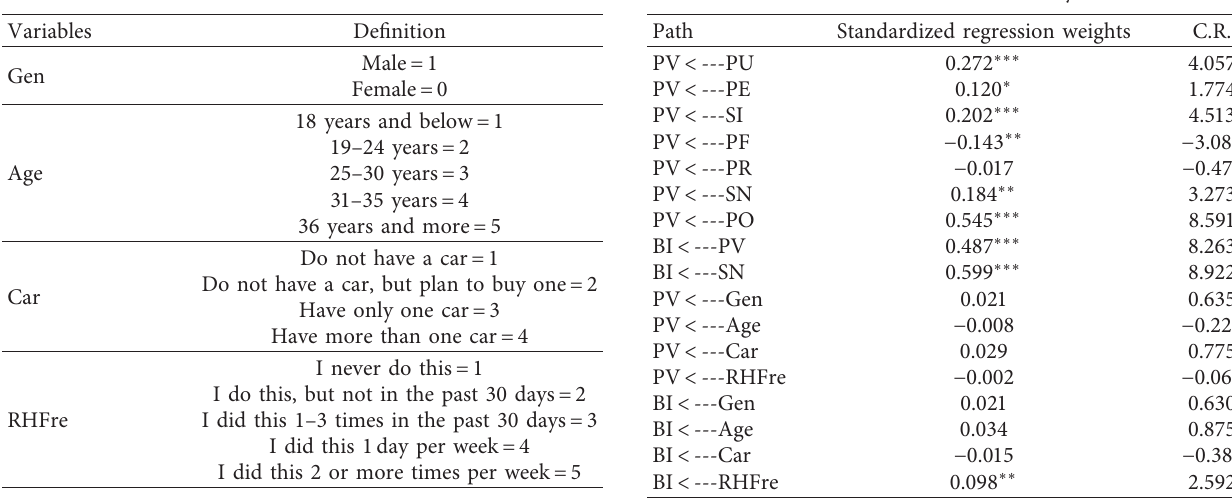
Table 5: Control variables. Table 6: Results of SEM